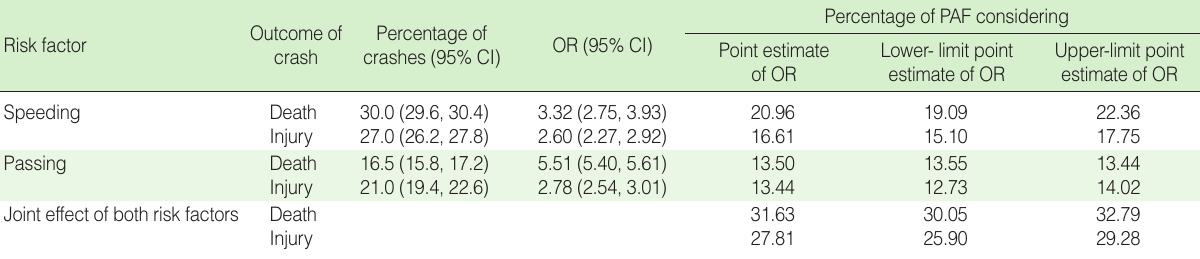
Joint effect of both risk factors CI, confidence interval; OR, odds